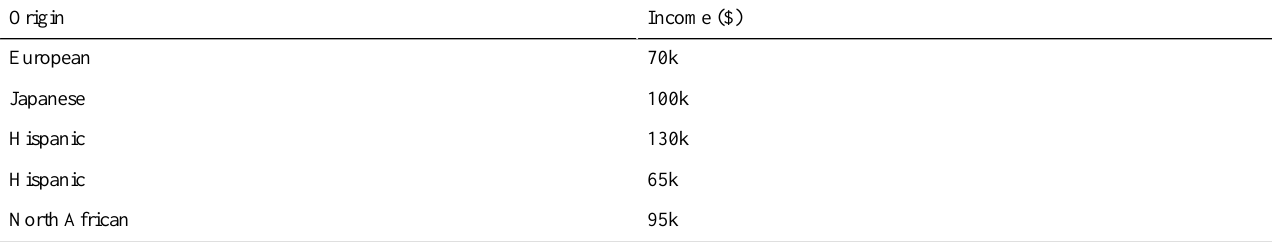
Table 2. Example of a real sample, with one’s origin as the quasi-identifier and one’s income as the sensitive variable.